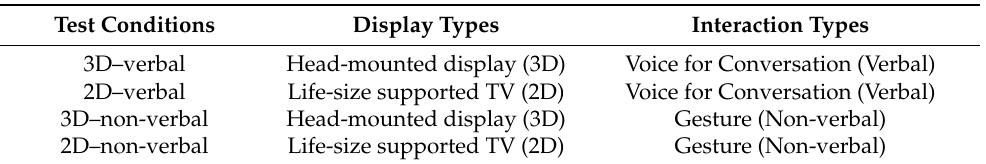
Table 2. The four experimental conditions: the configured factors consisted of display types (large 2D TV vs. 3D immersive HMD) and interaction types (verbal vs. non-verbal).